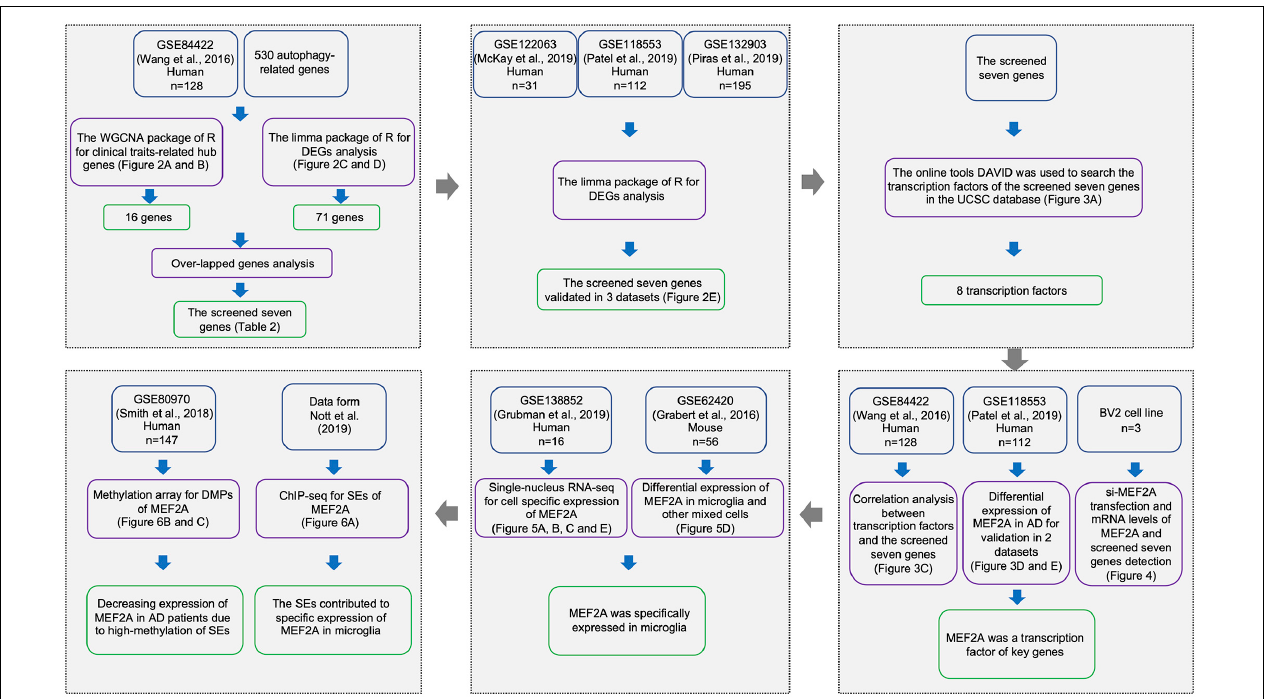
FIGURE 1 | Workflow of sample procedures. The samples and data sources are shown in blue boxes, methods for data processing are shown in purple boxes, and results are shown in green